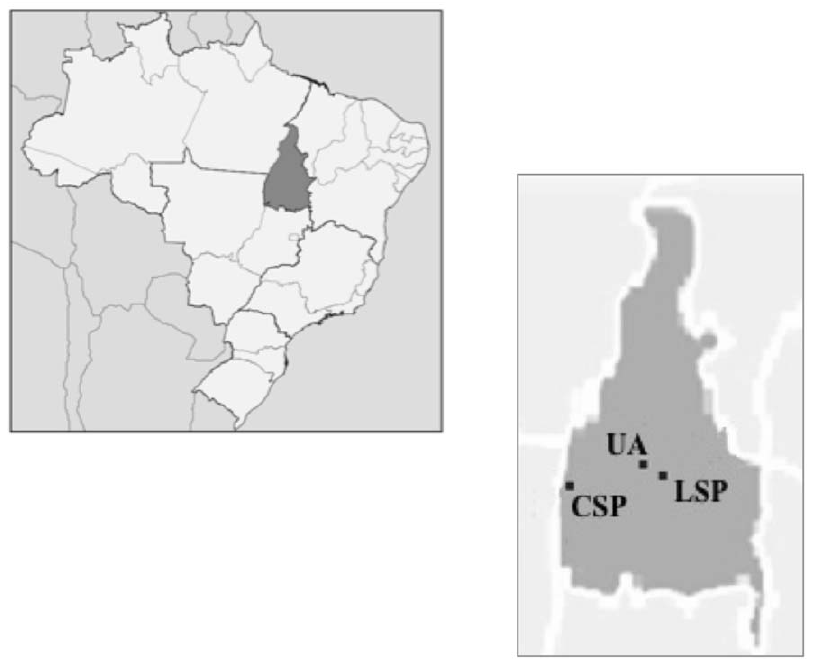
Figure 1. Phylogram of Plasmodium spp. and Haemoproteus spp. lineages in community birds. Phylogenetic relationships of the 21 haemosporidian parasite lineages found in three different habitats, based on cyt b sequences. Numbers located on the top of the branches indicate N ML bootstrap support (100 replications, only values above 50% are shown). The presence of each parasite lineage in the three areas studied is ), urban area ( m ) and natural area ( & ). indicated by: transition area (